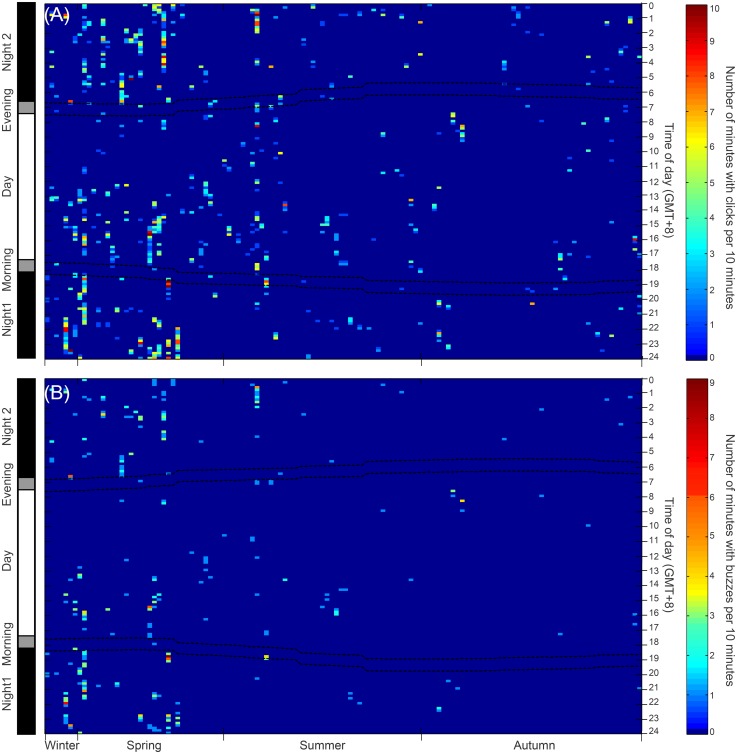
The daily occurrence of (A) dolphin click trains and (B) buzzesas a function of time of day and seasonal conditions.The dashed broken lines indicate the boundary of different dial phases. Times are given as local standard time (UTC + 8 hr).